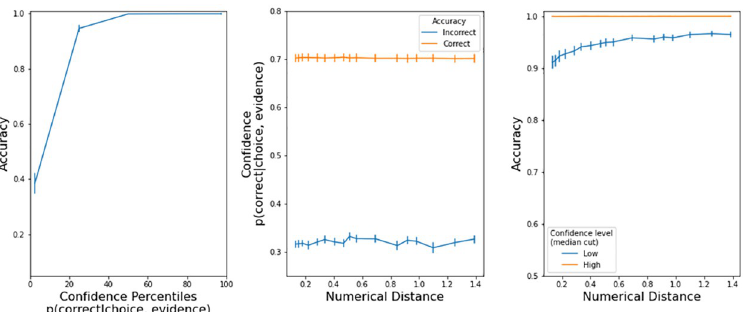
Fig 12. Confidence properties in the drift diffusion model (Exp 3). Left panels: accuracy increased with more confidence. Center panels: there was low confidence in incorrect trials. Right panels: accuracy is higher in high confidence trials. Error bars are s.e.m.